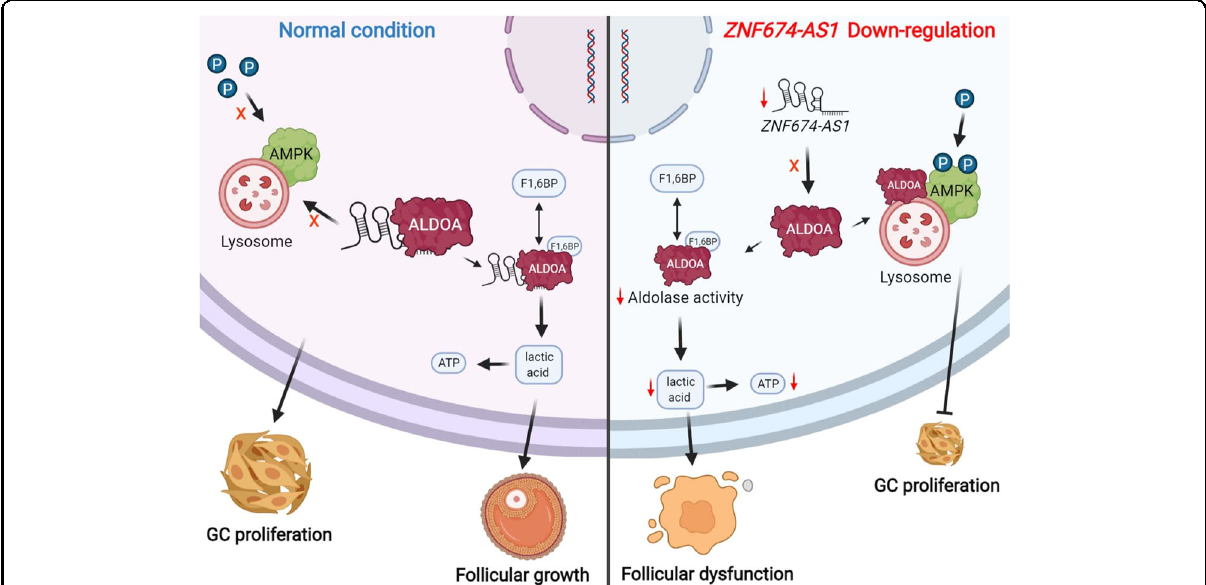
Fig. 7 Graphical abstract describes that ZNF674-AS1 regulates the glycolysis and proliferation of GCs. Down-regulated ZNF674-AS1 lead to the decreased enzymatic activity of ALDOA and promoted the activation of lysosome localized AMPK, therefore inhibiting the glycolysis and proliferation of